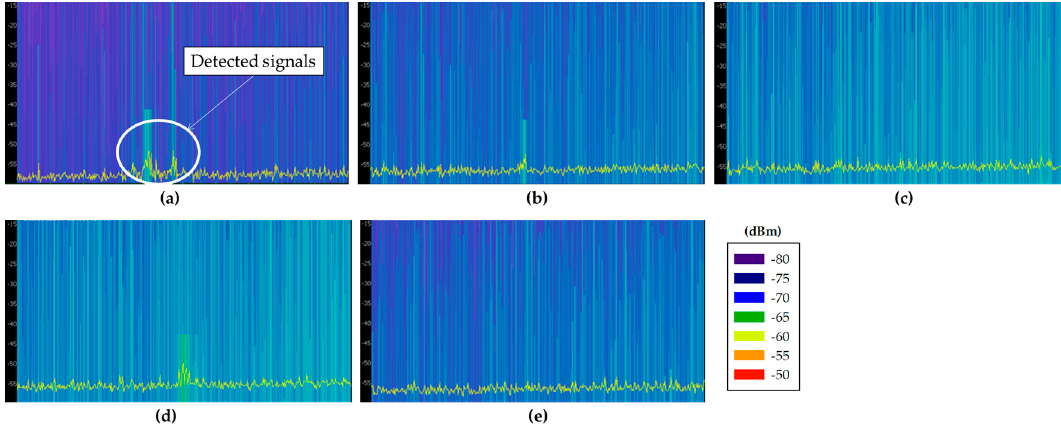
Figure 7. Measured spectrograms at 2.45 GHz central frequency with 100 MHz bandwidth: ( a ) within Box 2; ( b ) within Box 18; ( c ) aisle in front of Box 6; ( d ) aisle in front of Box 18; and ( e ) in the middle of the scenario.